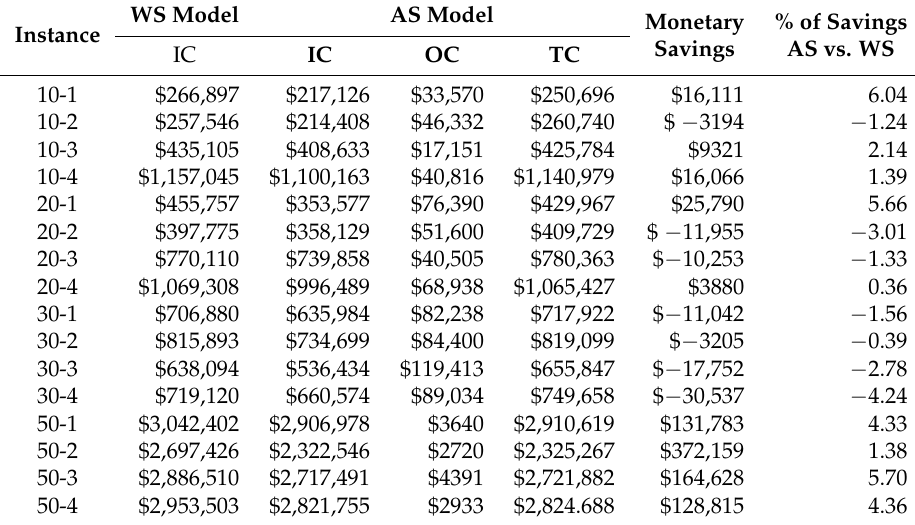
Table 8. Comparison between the total inventory costs for the model with and without shortage for the test random instances. IC, Inventory Cost; OC, Opportunity Cost; TC, Total Cost.